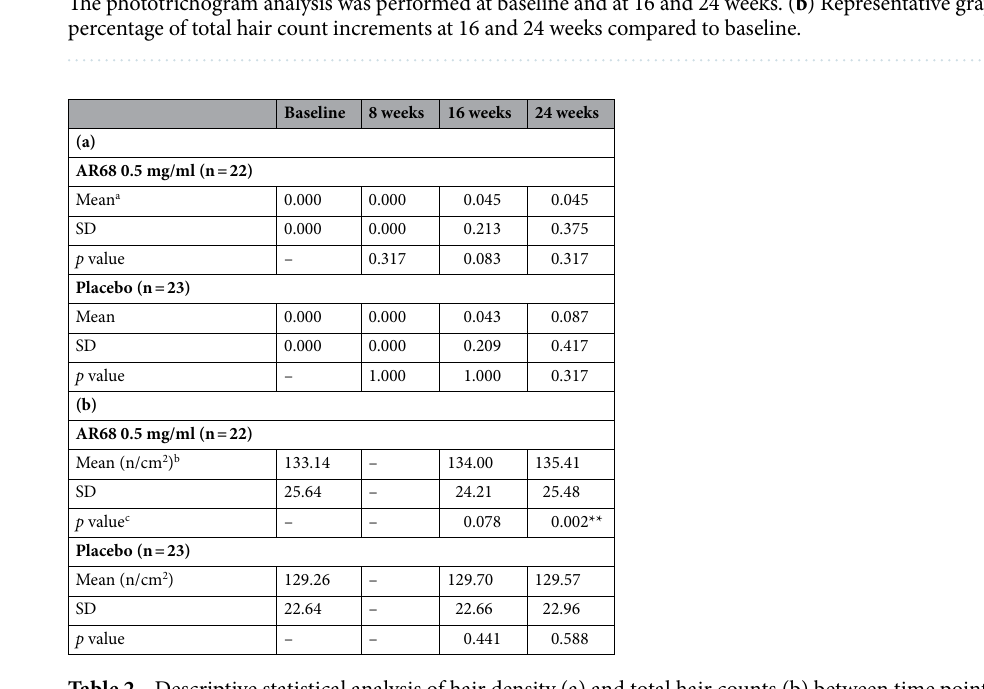
Table 2. Descriptive statistical analysis of hair density (a) and total hair counts (b) between time points in clinical study I. a Increment of mean value represents improvement of hair condition on hairline and vertex. b Increment of mean value represents improvement of hair counts. c Significantly different at ** p < 0.01 compared with